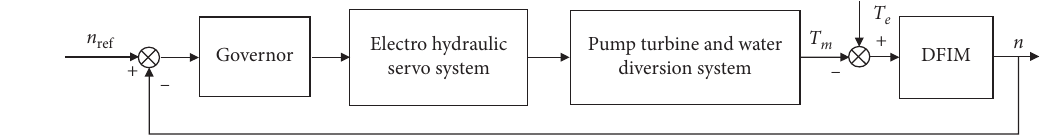
Figure 3: Adjustment system of the pump turbine.